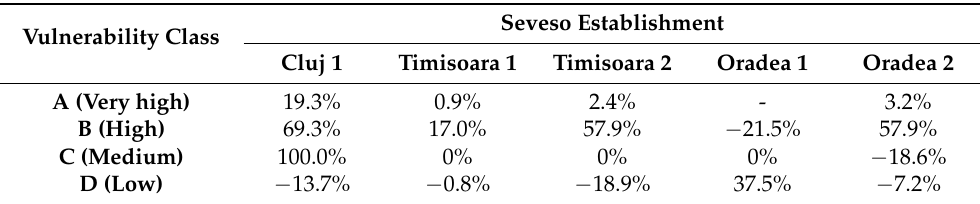
Table 5. Summary of vulnerability level variation between 2006 and 2018 within the area with reversible effects for worst-case